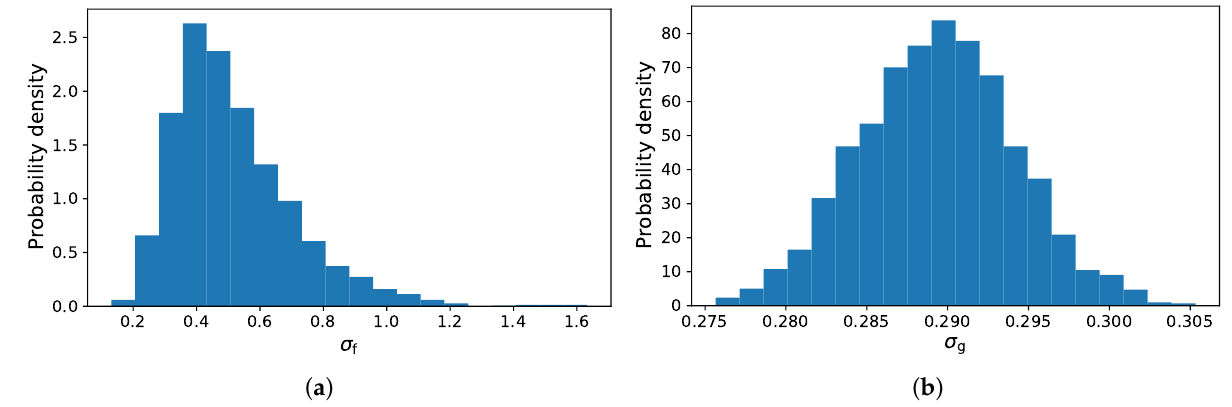
Figure 6. Marginal probability distributions of the uncertainty parameters, ( a ) σ f and ( b ) σ g